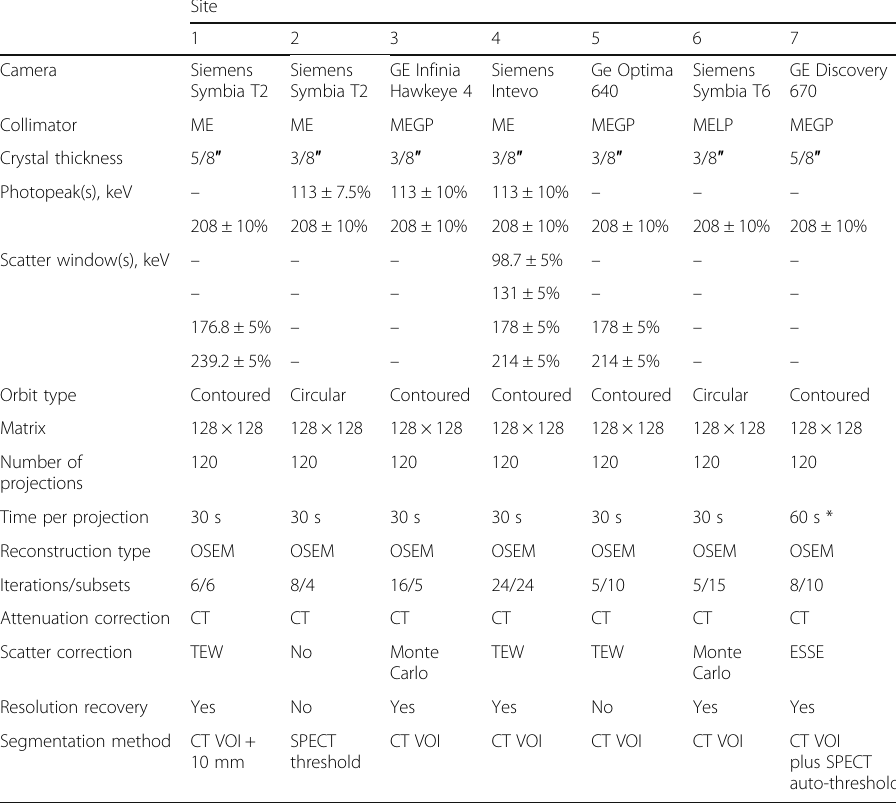
Table 2 Summary of acquisition and processing parameters used. See text for full